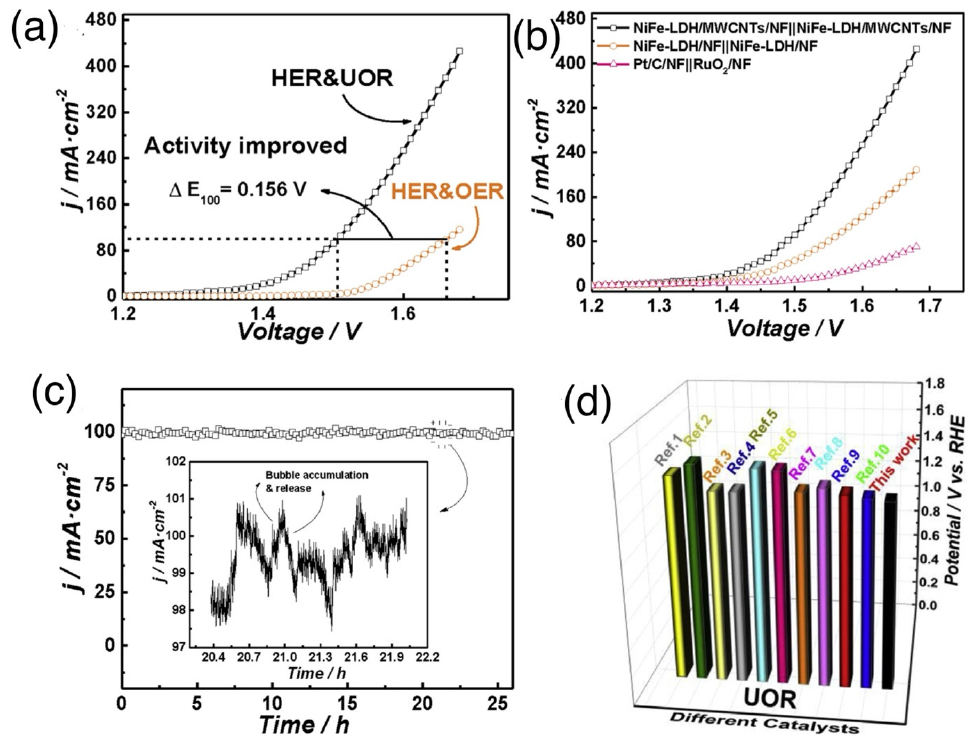
Figure 19. ( a ) LSVs of water electrolysis and water-urea electrolysis, ( b ) LSVs, ( c ) chronoamperometric responses of NiFe-LDH/MWCNTs/NF||NiFeLDH/MWCNTs/NF and ( d ) comparison of the potentials of different catalysts during the UOR. Reprinted with permission from Ref. [91].